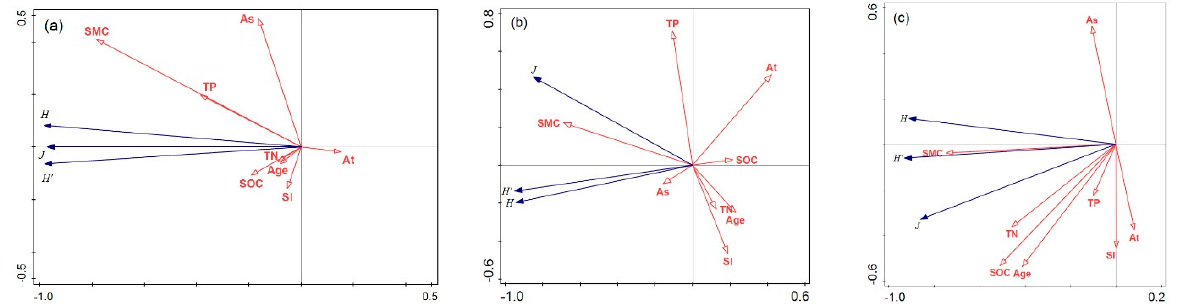
Figure 5. Redundancy analysis of species diversity of ( a ) overall community, ( b ) layer II, and ( c ) layer I with environmental factors. SOC, soil organic carbon; TN, total N; TP, total P; SMC, soil moisture content; Sl, slope; As, aspect; At, altitude.